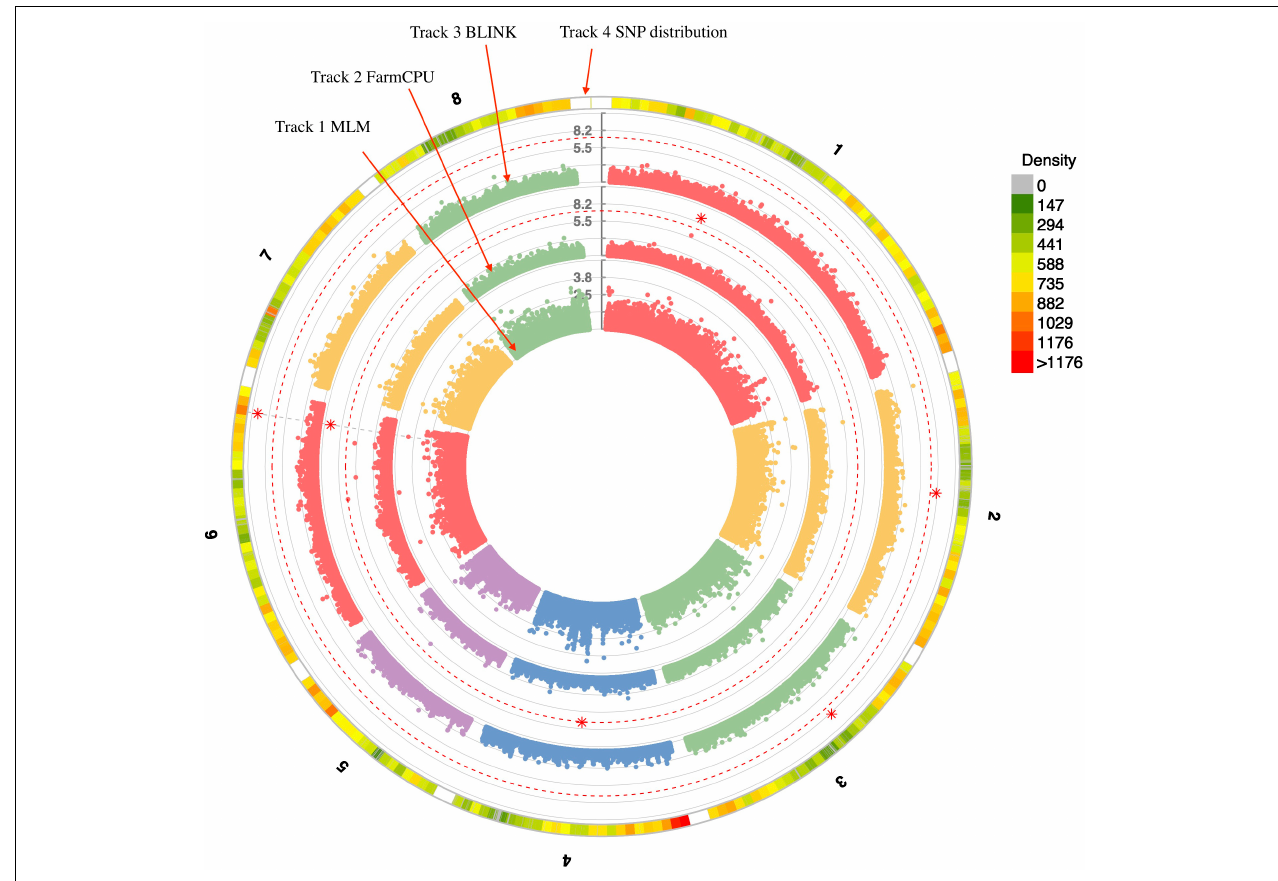
FIGURE 4 | Distribution of SNPs on the eight chromosomes. Tracks 1, 2, and 3 represent results from three statistical analysis models used for genome-wide association study (GWAS) of peach gummosis disease. Track 4 represents filtered SNPs on the eight peach chromosomes. The red dotted-line indicates the significance threshold (-log 10 P = 6). The red asterisks represent the significant SNP.